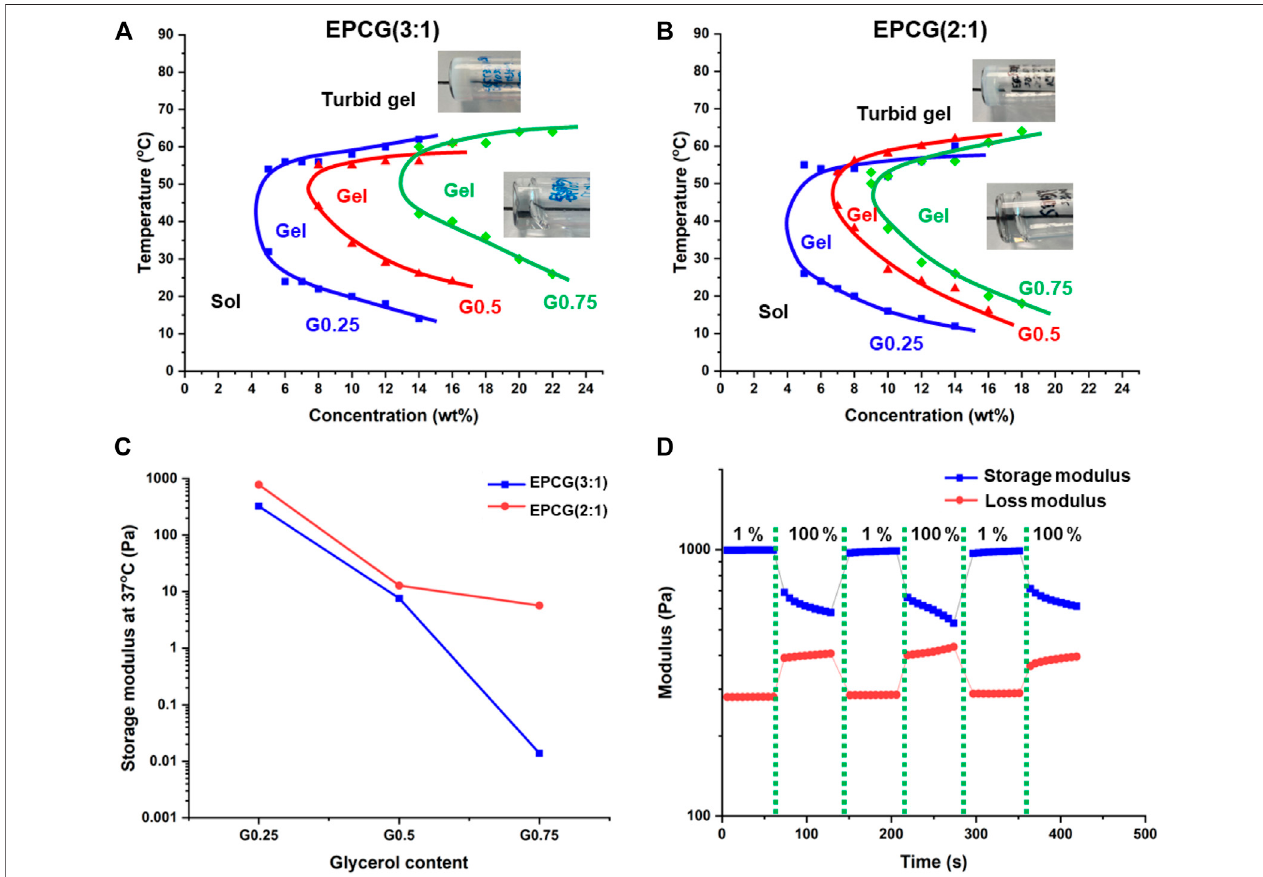
FIGURE4| Effectofpolymerbranchingonthetemperature-concentrationphasediagramsof (A) EPCG(3:1)and (B) EPCG(2:1)seriesofthermogels.Thepictures are representative images of the gels and turbid gels formed. More images are provided in Supplementary Figure S6 . (C) Effect of polymer branching on EPCG thermogels ’ storage moduli. Measurements were obtained via rheology temperature sweep of thermogels at 3 ° C min − 1 , 1% strain, and 1 Hz. (D) Representative rheological measurement ofEPCG thermogel [EPC (2:1)G0.25 15 wt%] subjectedtorepeated low(1%)and high strains (100%) at 1 Hzshows that thethermogel has good shear thinning ability and good